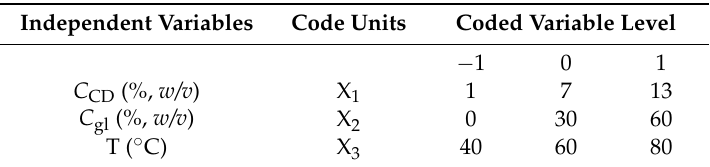
Table 1. Experimental values and coded levels of the independent variables used for the 2 3 full-factorial design.